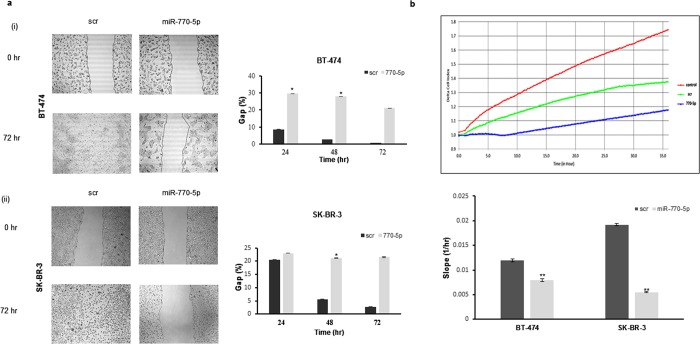
miR-770-5p regulates motility and invasion in BT-474 and SK-BR-3 cells.(a) The rate of motility was assessed by wound-healing assay. Wound closure was observed in scrambled control-transfected cells in a time-dependent manner while miR-770-5p mimic transfected cells lost their motility (n = 2, *p<0.005). (b) Cell invasion analysis was performed by xCELLigence real-time cell analyzer measuring impedance-based signals. Cell invasion capacity decreased in both of the cells transfected with miR-770-5p mimic compared to scrambled control-transfected cells (n = 2, **p<0.0001).